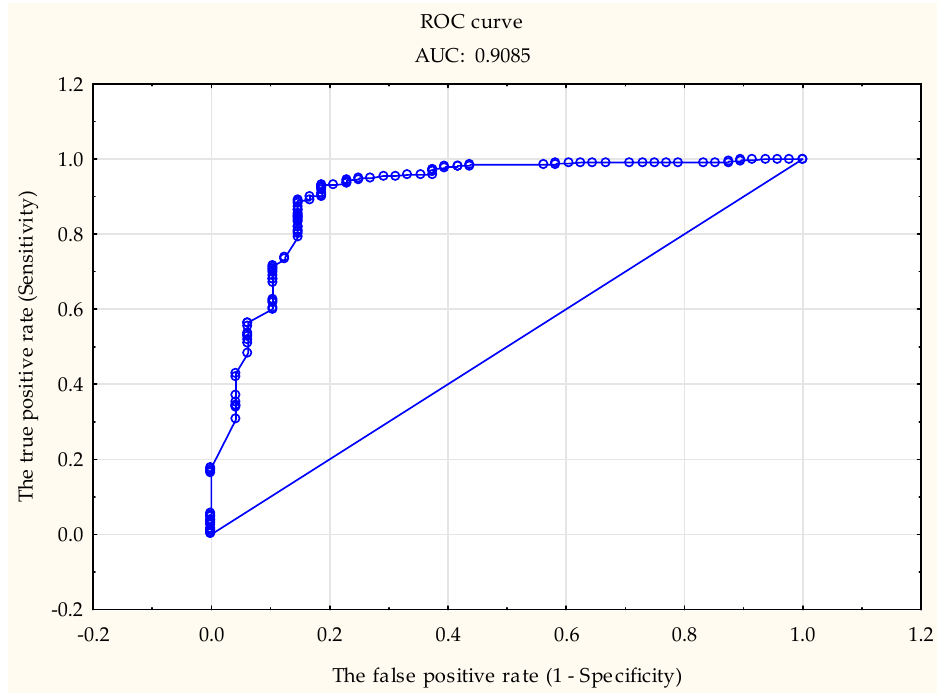
Figure 1. ROC curve for the Polish ICT sector—eco-innovation equation. Source: own calculation with Statistica software support based on questionnaire research. Table 4. Matrix of case classification—Polish ICT sector. Classification of Objects Based on the Logit Model Real Belonging of Objects Predicted: 0 Predicted: